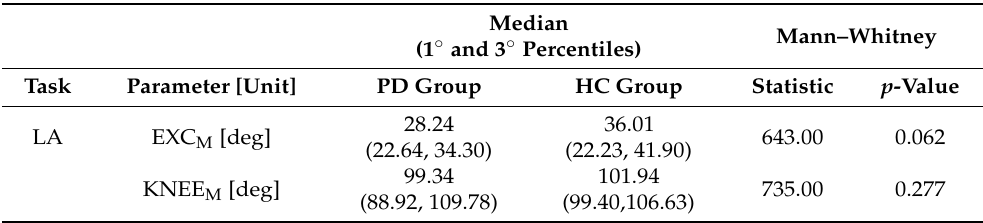
Table 3. Median and percentiles (first and third) related to each evaluative motor task for PD and HC groups, with test statistic, p -value, and significance